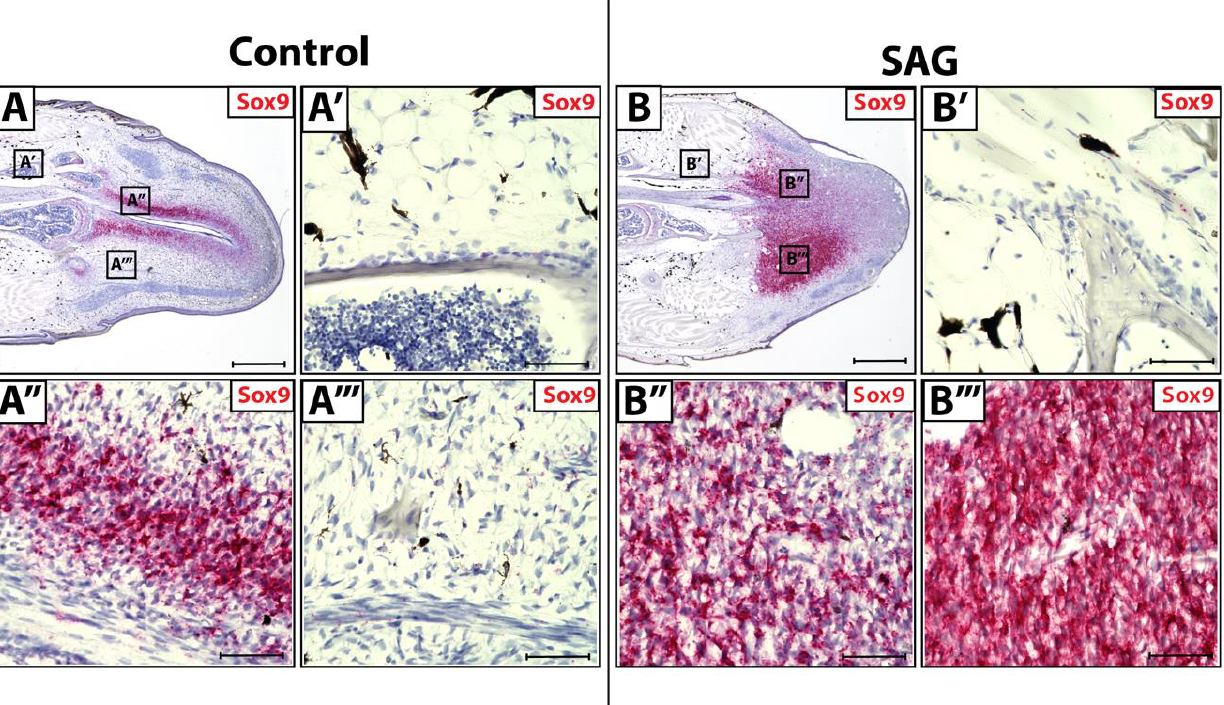
Figure 3. Sox9 expression in control and SAG-treated blastema tails. ( A ) Control and ( B ) SAG-treated blastemas (D14) analyzed by histology/in situ hybridization for Sox9 expression ( A’ – A’’’ ) Higher magnification of regions identified in Panel A highlighting ( A’ ) original tail FCTCs, ( A’’ ) blastema FCTCs medial to regenerated spinal cord and ( A’’’ ) blastema FCTCs lateral to the regenerating spinal cord. ( B’ – B’’’ ) Higher magnification of regions marked in Panel B showing ( B’ ) original tail FCTCs, ( B’’ ) medial and ( B’’’ ) lateral blastema FCTCs with respect to the regenerating spinal cord. ( A , B ) Scale bar = 500 µM. ( A’ – A’’’ , B’ – B’’’ ) Scale bar = 50 µM.